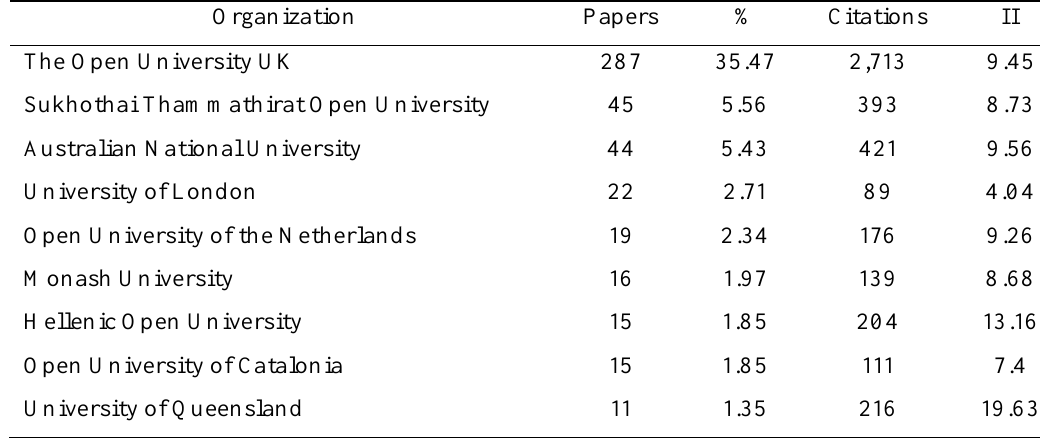
Organizations With the Most Output on OUs